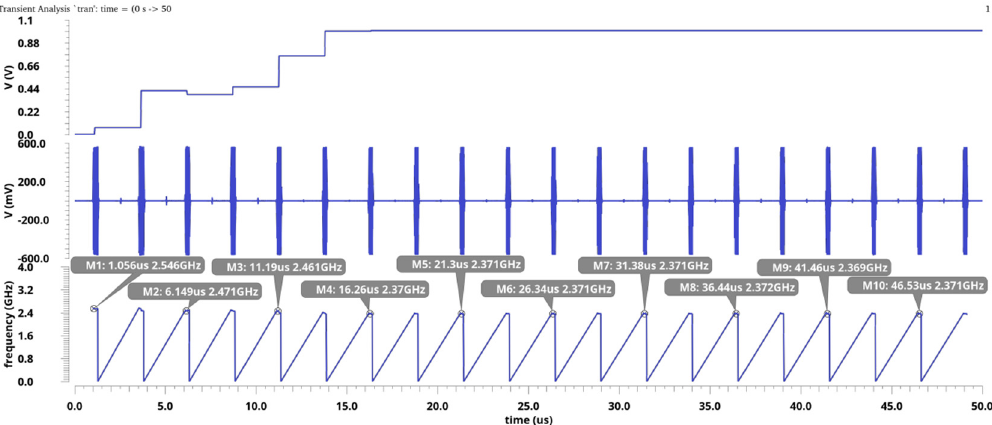
Figure 20. The simulation results without the proposed initial phase error reduction, sequentially including: the control voltage, SRO’s output signal, and the frequency calibration results (the calibration results in each quenching cycle have been labeled).